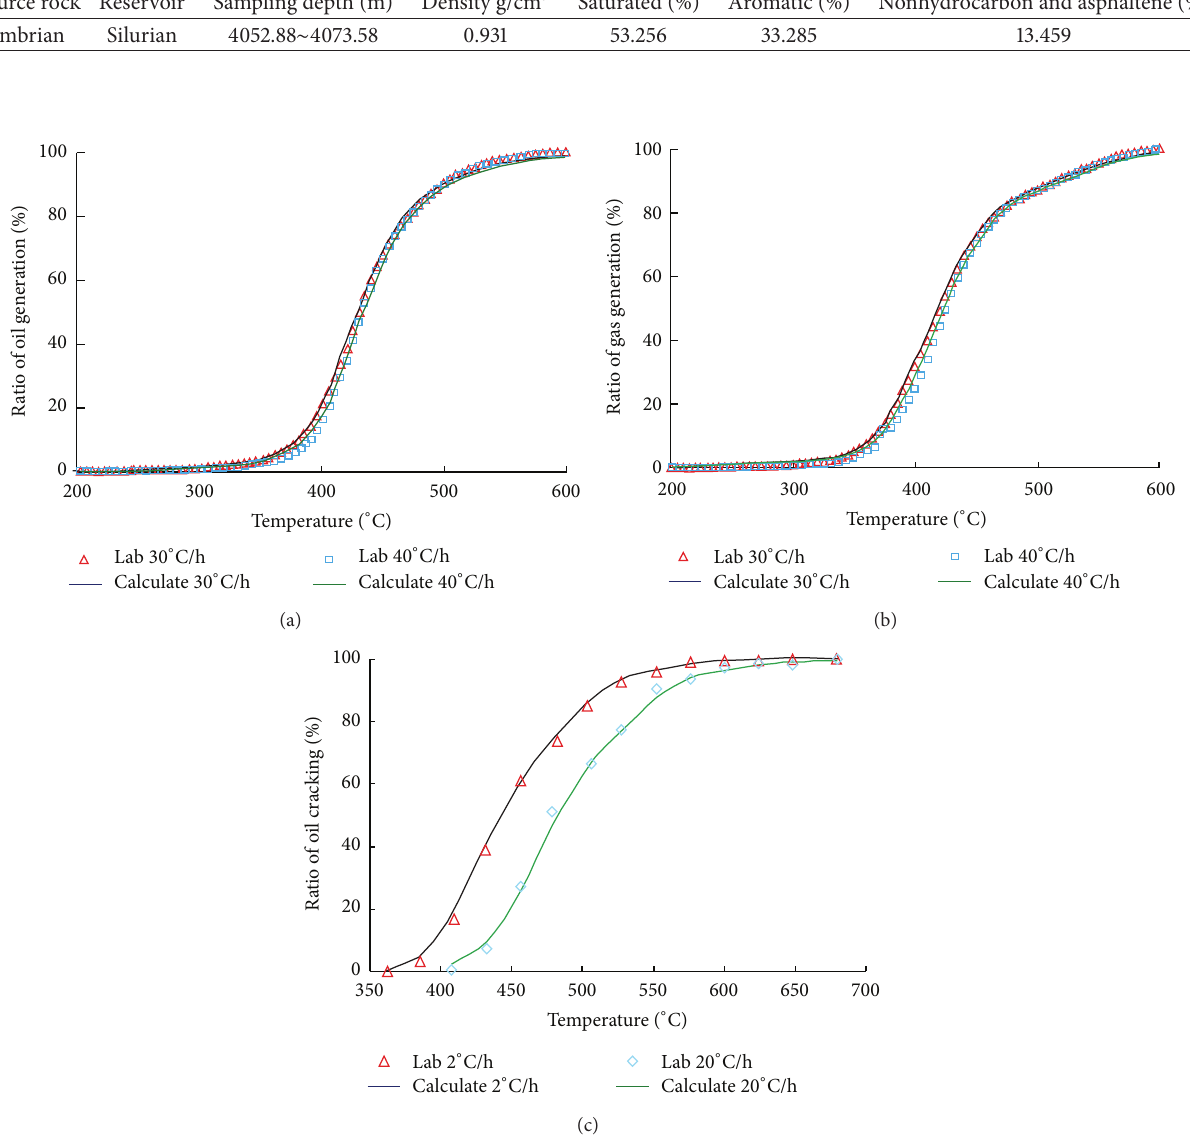
Figure 2: The transformation ratio of oil and gas generated from organic matter at different temperatures and heating rates. (a) The transformation ratio of oil generated from kerogen of Xiamaling Shale. (b) The transformation ratio of gas generated from kerogen of Xiamaling Shale. (c) The transformation ratio of gas generated from oil